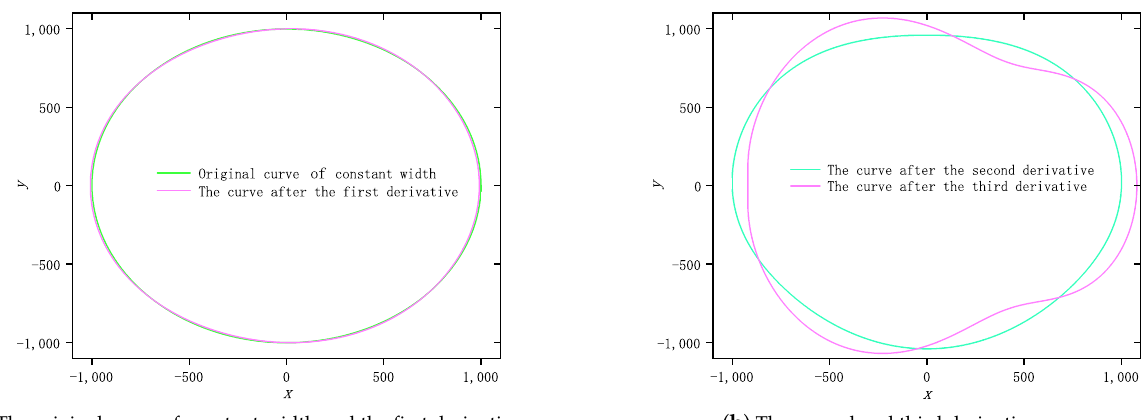
The curve after the second derivative The curve after the third derivative